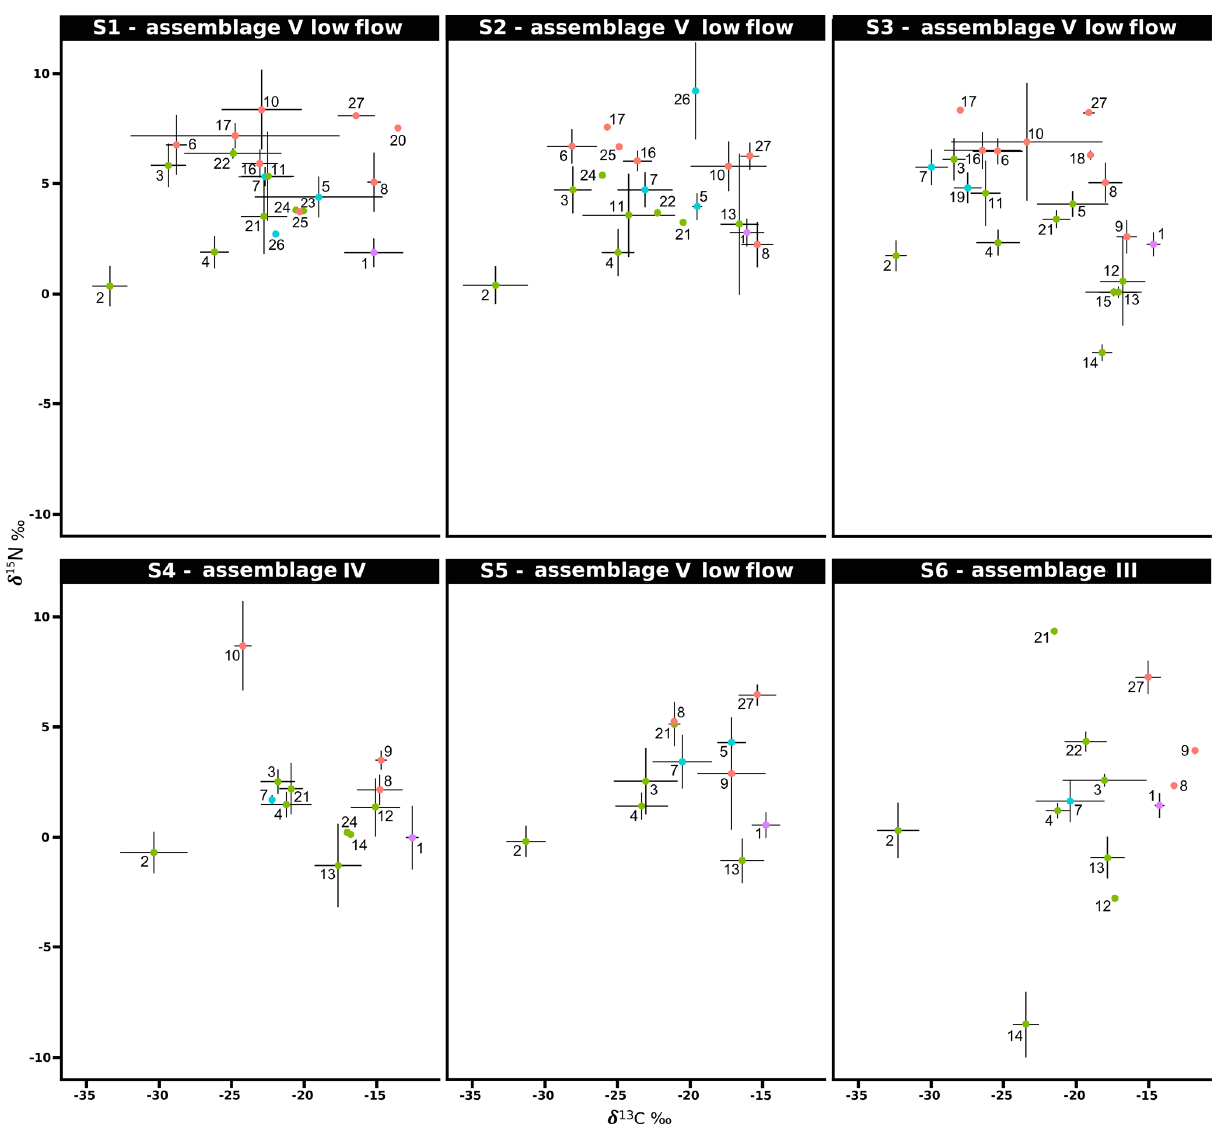
Figure 4. Stable isotope bi-plots showing vent consumers’ isotope signatures (mean δ 13 C versus δ 15 N values ± standard deviation)